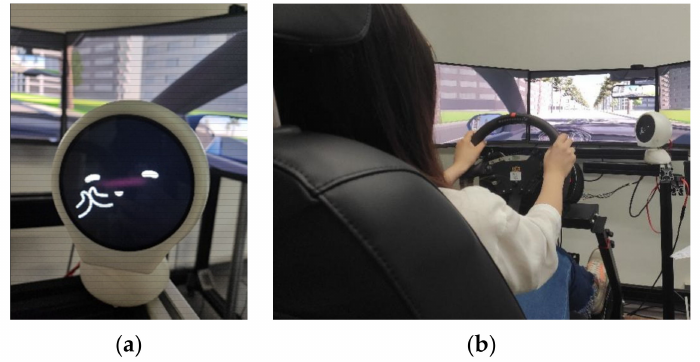
Figure 2. ( a ) Images of the robot ‘XiaoV’. ( b ) Experiment